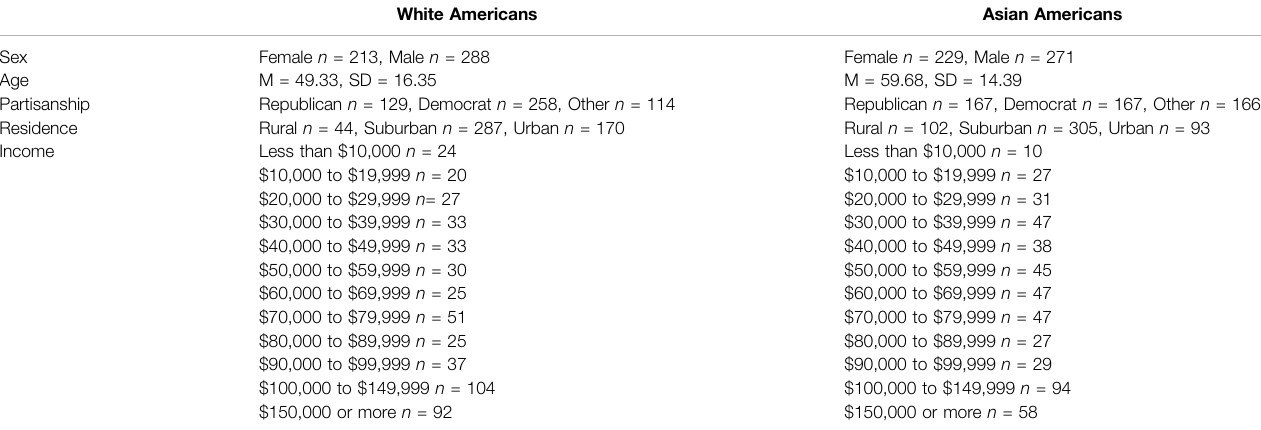
TABLE 1 | Demographic characteristics of study sample.